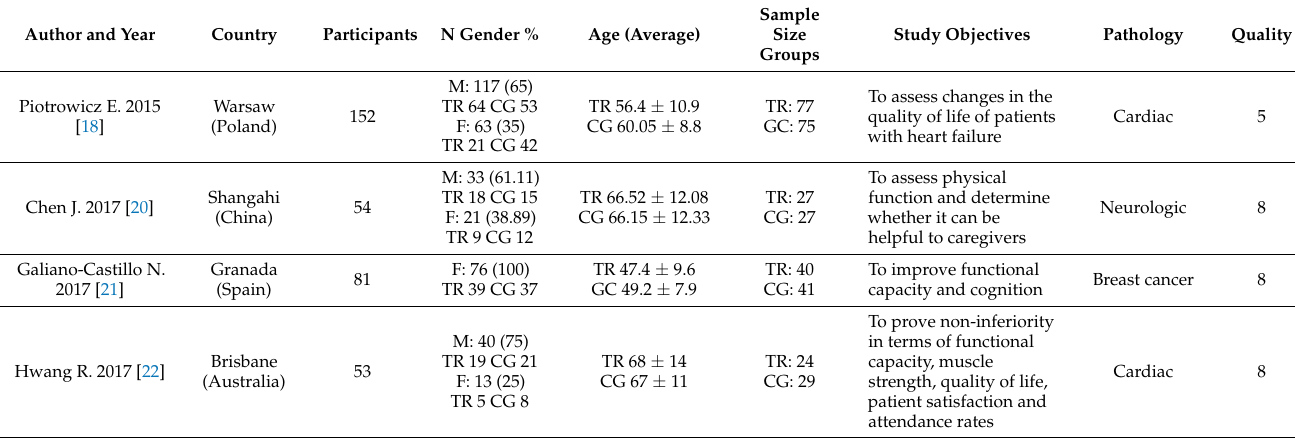
Table 4. Detailed information of selected